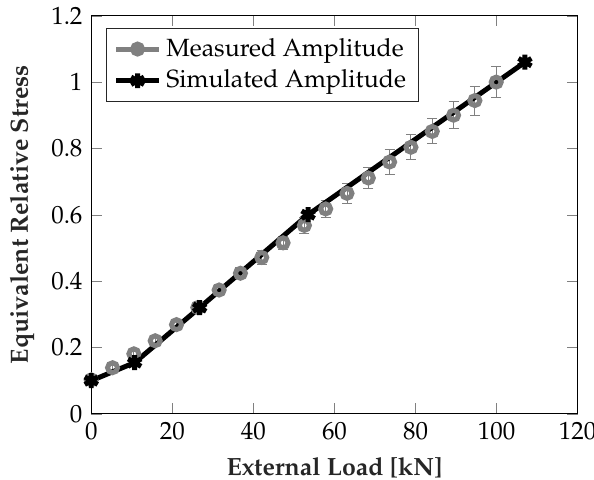
Figure 11. Simulated and measured difference signal amplitude at different loads, depicting one standard deviation for measurement